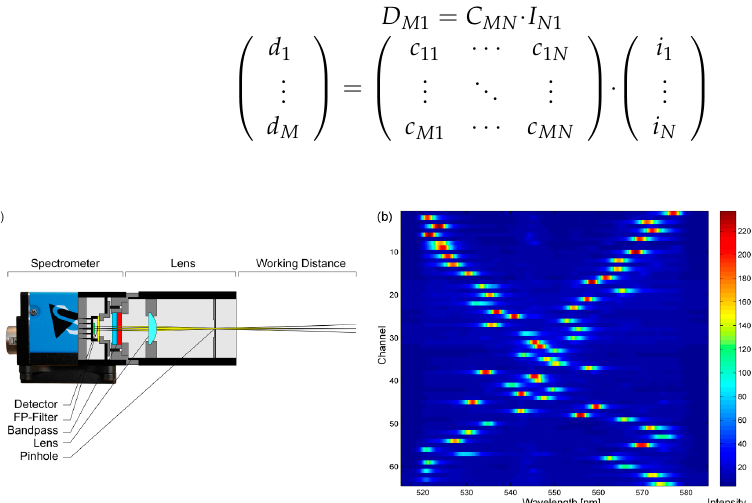
Figure 7. Laboratory demonstrator. ( a ) Schematic cross-section of the demonstrator, consisting of a monochrome CCD camera with integrated FP filter array, bandpass filter and telecentric lens. ( b )